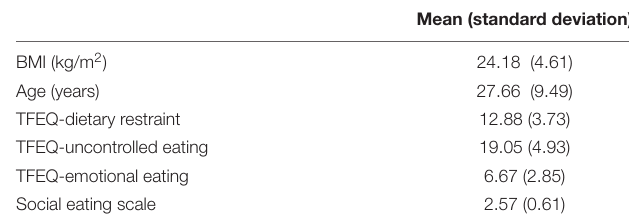
TABLE 3 | Participant characteristics Study